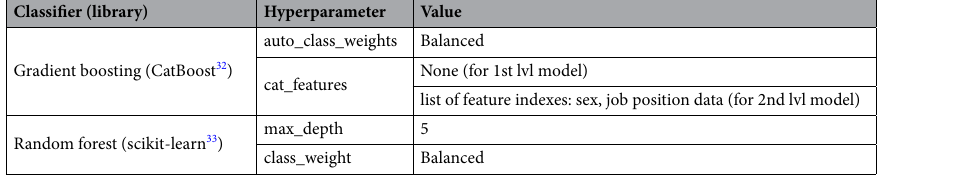
Table 10. Hyperparameters of standard models used in the